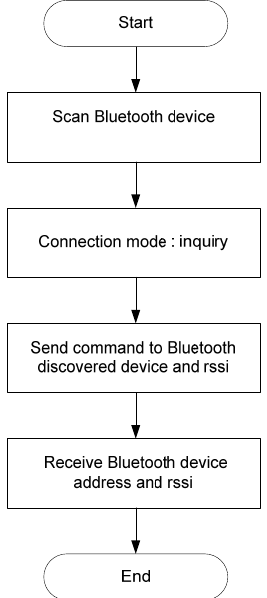
Figure 5. Flow chart of Bluetooth inquiry received signal strength Indicator (RSSI).